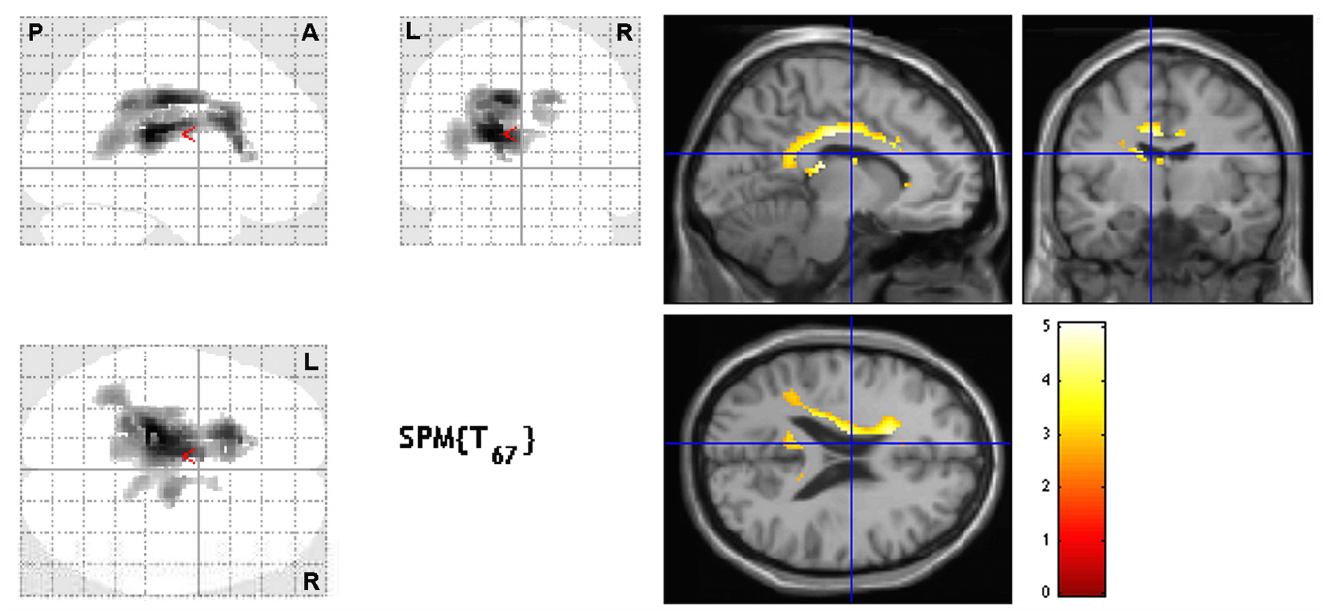
Fig 1. SPM map. Positive correlation between brain perfusion and dichotic listening (left ear words) normalized scores with adjustment for age, sex, socio- cultural level and time delay between brain SPECT and neuropsychological testing. Linear regression analysis shows diffuse impairment of periventricular areas/corpus callosum. Significant clusters are displayed with T-score values on 2-dimensional projections (glass-brain — left panel) and slices of MRI (right panel) templates in axial, coronal and sagittal orientations. P -value < 0.005 at the voxel level for clusters (cid:1) 100 contiguous voxels (corrected for cluster volume). L, left; R, right; A, anterior; P,